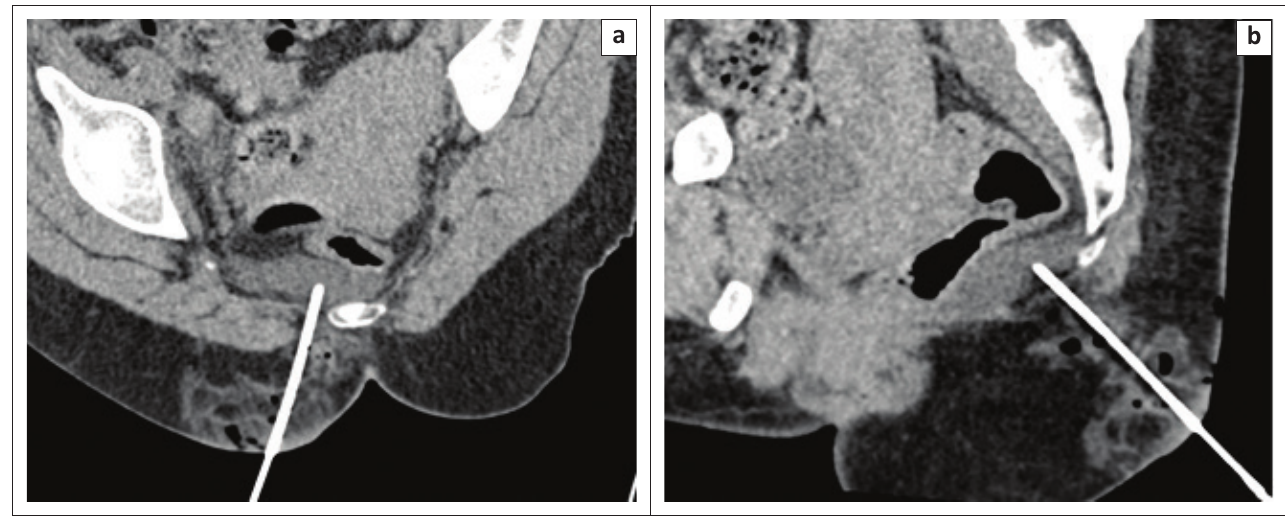
FIGURE 3: (a and b) Oblique axial and sagittal images after instillation of 0.9 % saline showing anterior displacement of the rectum and widening of the presacral